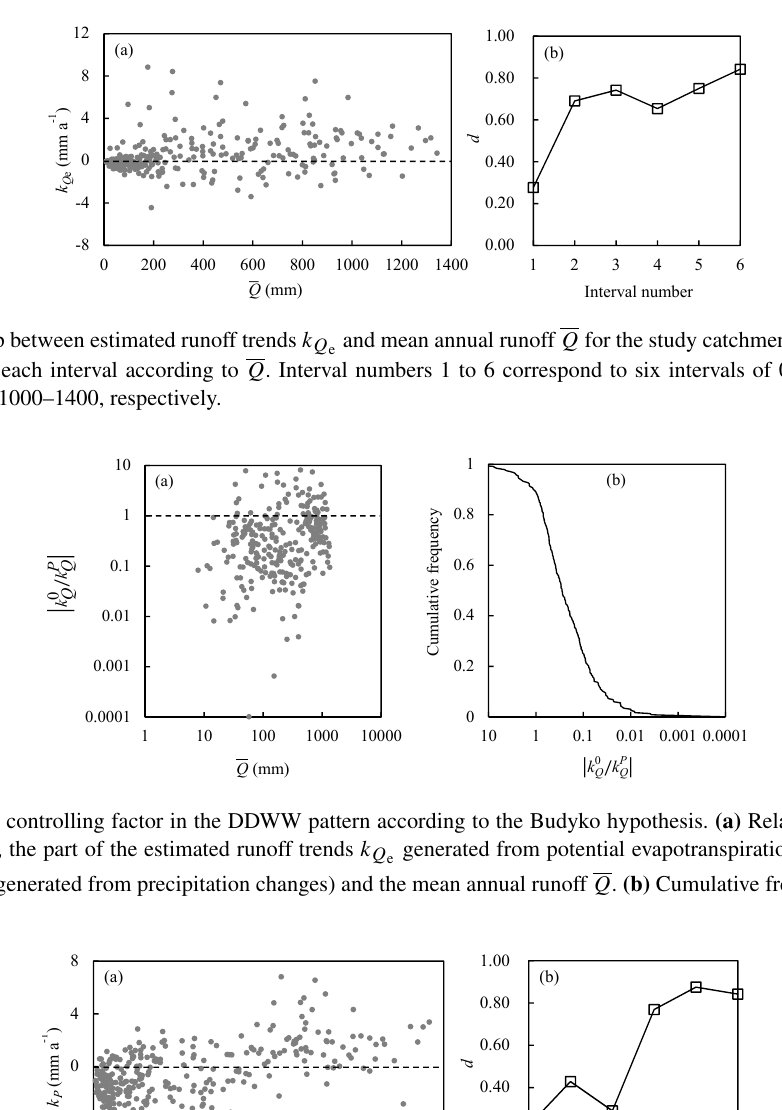
Figure 10. (a) Relationship between observed precipitation trends k P and mean annual runoff Q for the study catchments during the pe- riod 1956–2000. (b) Values of d in each interval according to Q . Interval numbers 1 to 6 correspond to six intervals of 0–200, 200–400, 400–600, 600–800, 800–1000, and 1000–1400,